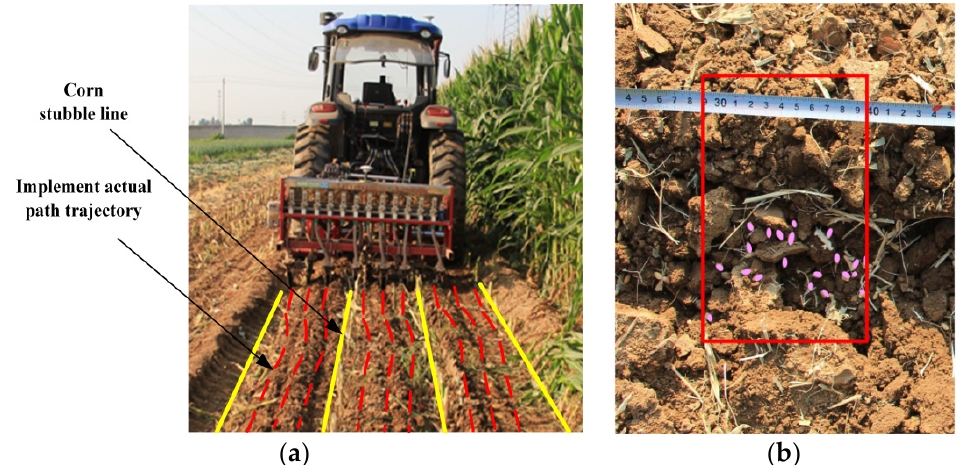
Figure 14. Field verification and test site conditions. ( a ) stubble avoidance by seeder. ( b ) distribution of seeds. Note: The red and yellow lines are the corn stubble line and the implement actual path trajectory line, respectively.